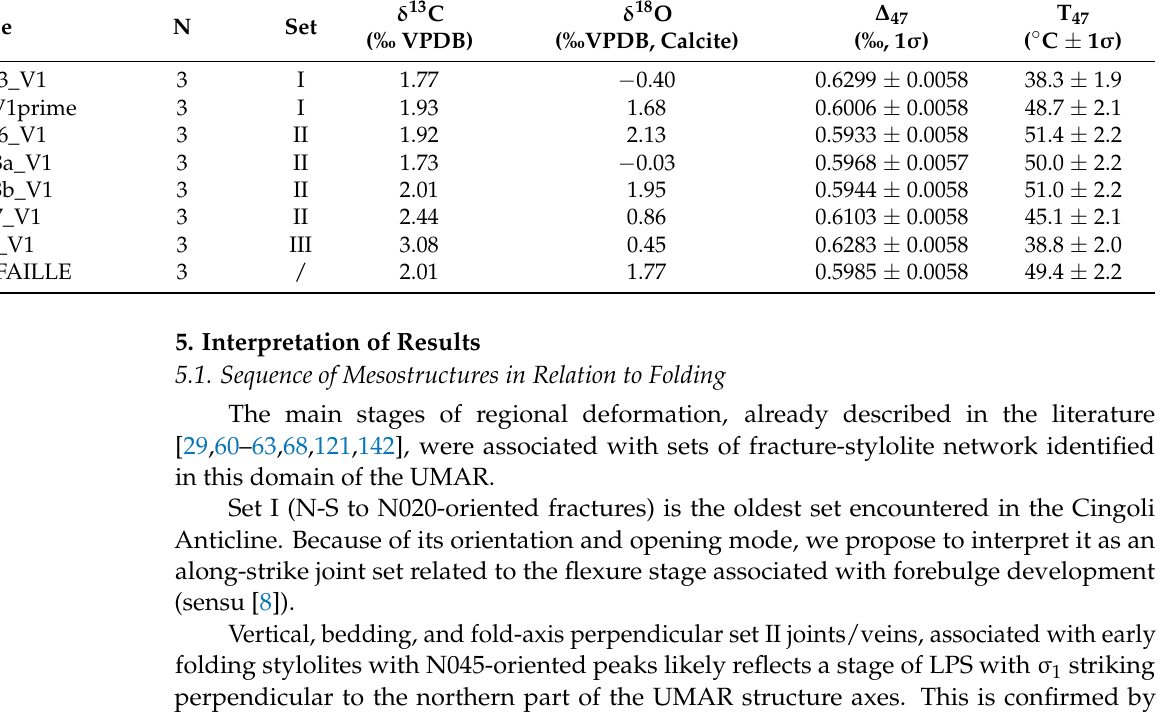
Table 3. Results of clumped isotope measurements, with ∆ 47 ratio and associated temperature of precipitation T 47.